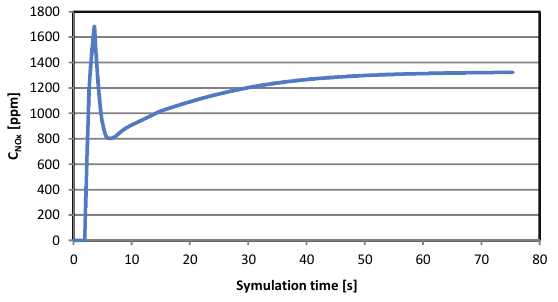
Fig. 9. Concentration of nitrogen oxides during simulation